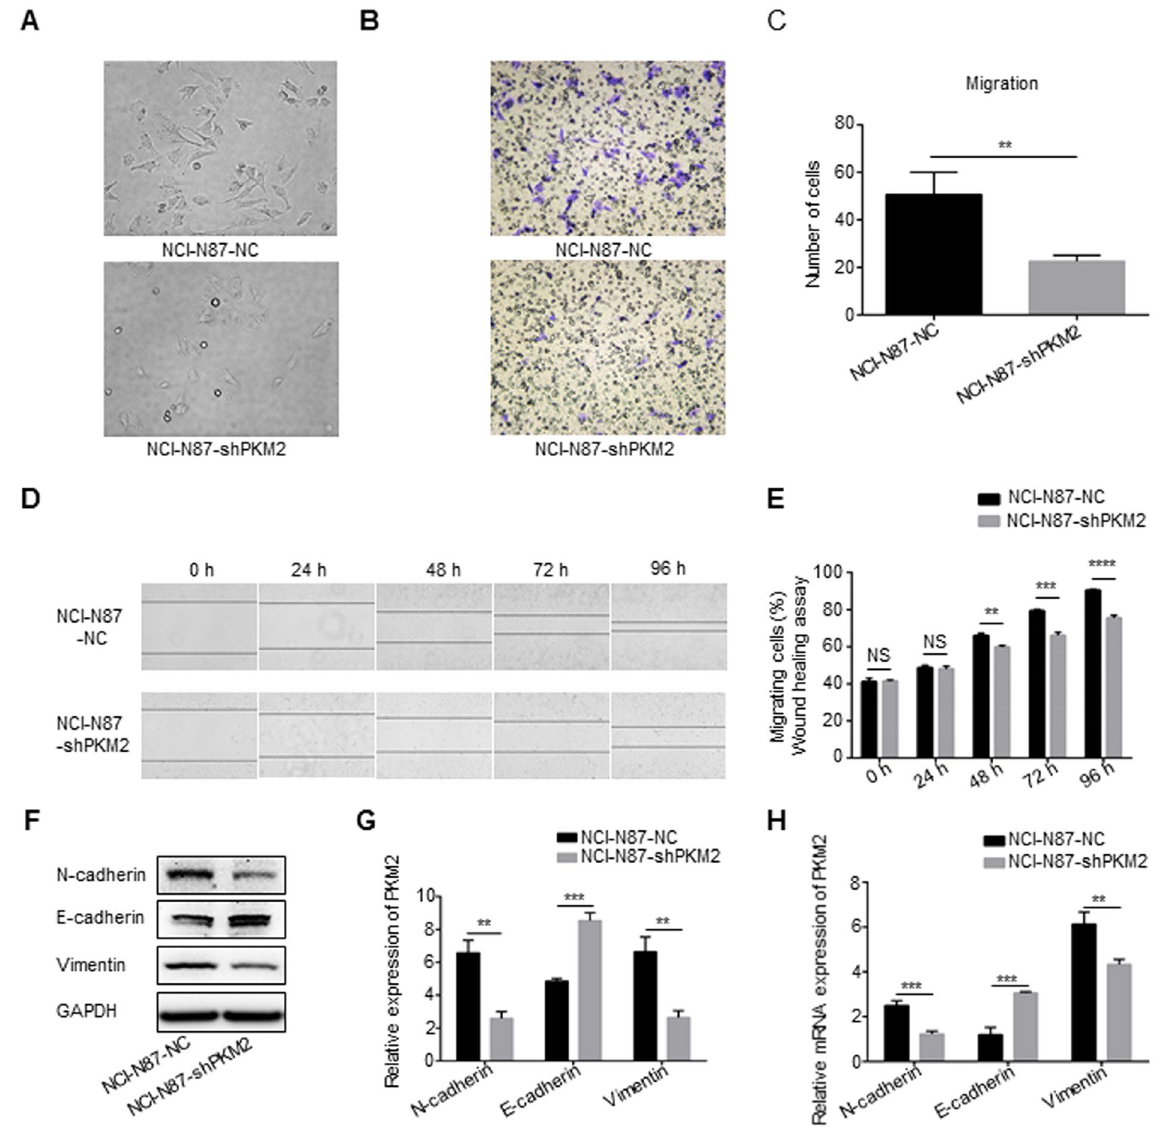
Figure 3. PKM2 knockdown inhibits the migration and mobility of NCI-N87 cell. ( A ) Knockdown of PKM2 reversed aggressive morphological characteristics in NCI-N87 cells (100 × magnification). ( B and C ) Silencing of PKM2 expression led to lower migration rate in NCI-N87 cells. Representative photomicrographs showing that at the 24 h time point migrated cells were present (200 × magnification). The data represent the mean ( ± SD) from three independent experiments. ( D and E ) Wound healing assays were performed in the NCI- N87 cells with different expression levels of PKM2 to investigate the cell mobility. Representative image of scratches at 0 h, 24 h, 48 h, 72 h and 96 h were shown. The results of the wound healing assays were also shown as graphs. The data represent the mean ( ± SD) from three independent experiments (40 × magnification). ( F , G and H ) Expression levels of N-cadherin, E-cadherin and Vimentin in stably transducted NCI-N78 cells were analyzed by western blot and qRT-PCR, quantitative western blot analysis results obtained using densitometric analysis and the mRNA expression levels which were standardized according to GAPDH. Full-length gels and blots are presented in the Supplementary files 2. The data represent the mean ( ± SD) from three independent experiments. ** P < 0.01. *** P < 0.001. **** P <